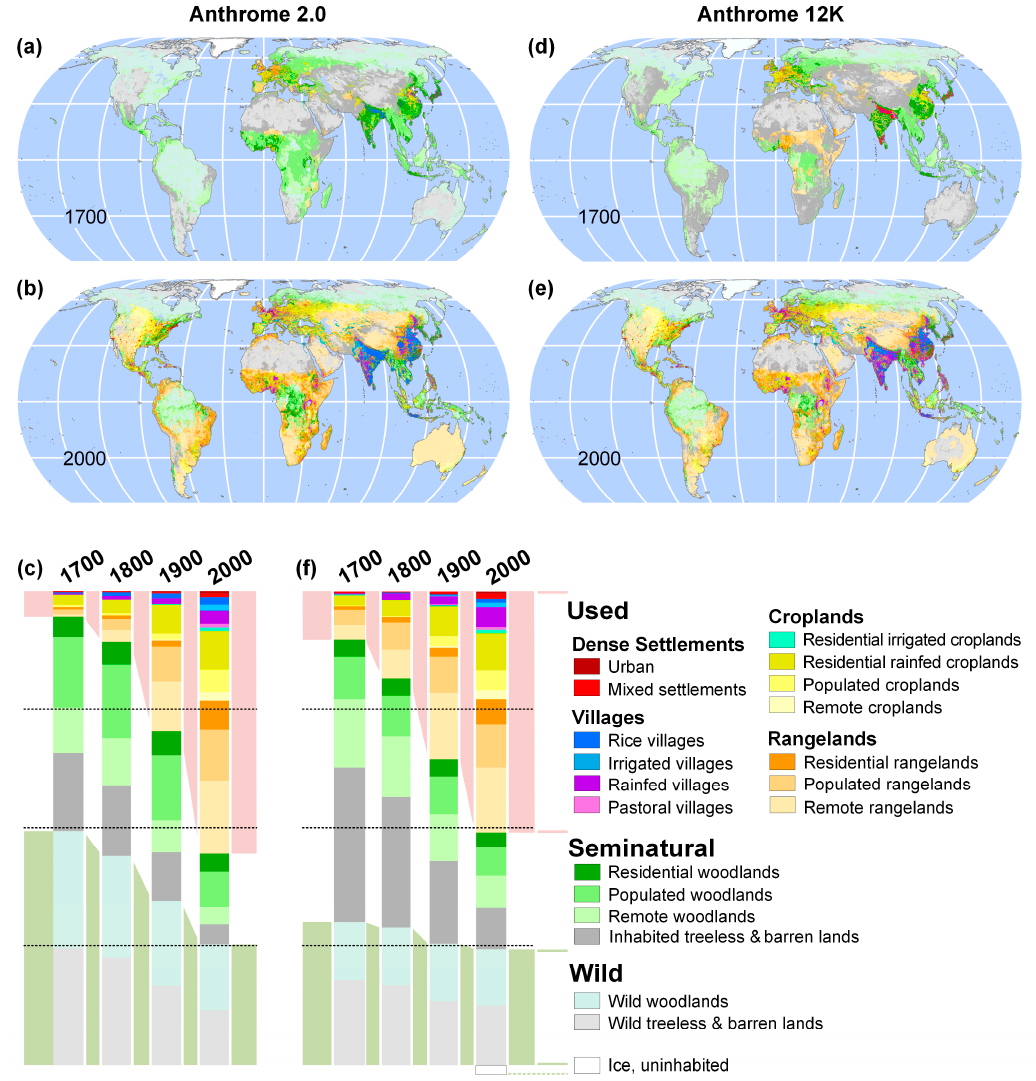
Figure 2. Comparison of Anthromes 2.0 and Anthromes 12K maps for 1700 and 2000 CE, and global area changes from 1700 to 2000 CE. Anthromes 2.0 maps for ( a ) 1700 and ( b ) 2000 and ( c ) changes in global land areas as percent ice-free land (stacked bars). Anthromes 12K maps for ( d ) 1700 and ( e ) 2000 and ( f ) changes in global land areas as percent ice-free land (stacked bars). Relative area of Ice, uninhabited is indicated for 2000 CE; this did not change significantly over time. Maps in Eckert IV